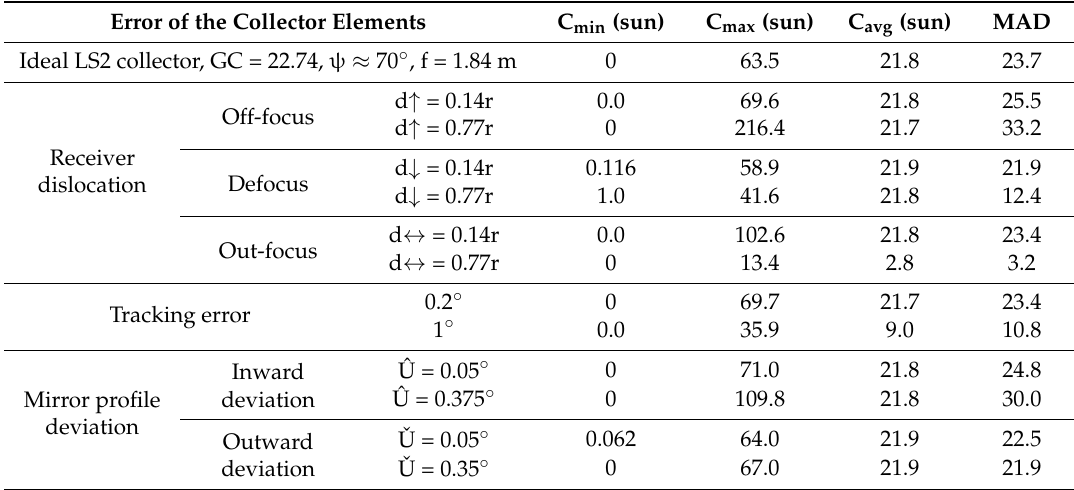
In the table: LS2 = Luz Solar 2, sun = unit of light concentration = 1 kW/m 2 ; C min , C max and C avg , and MAD stand for minimum, maximum and average light concentration, and Mean Absolute Deviation; GC = Geometric Concentration, ψ = rim angle, f = focus, d = amount of dislocation, r = radius of the receiver and the arrows show the directions of dislocation of the receiver from the focus of the